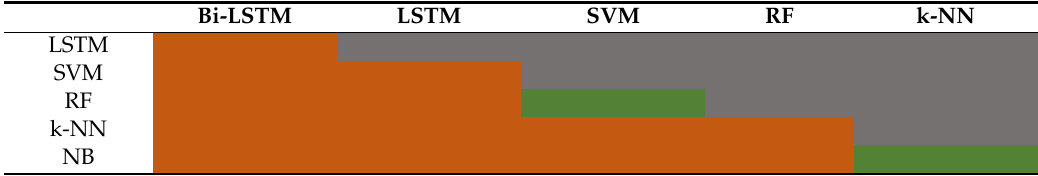
Table 5. McNemar test, where the green cells represent statistically equal models, and the red cells represent statistically di ff erent models, using a significance of